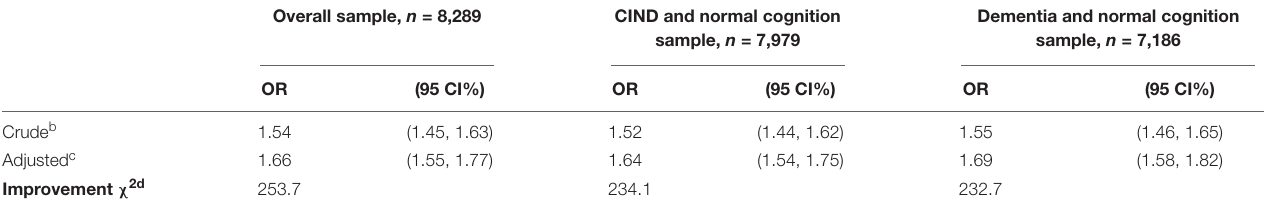
Overall sample, n =